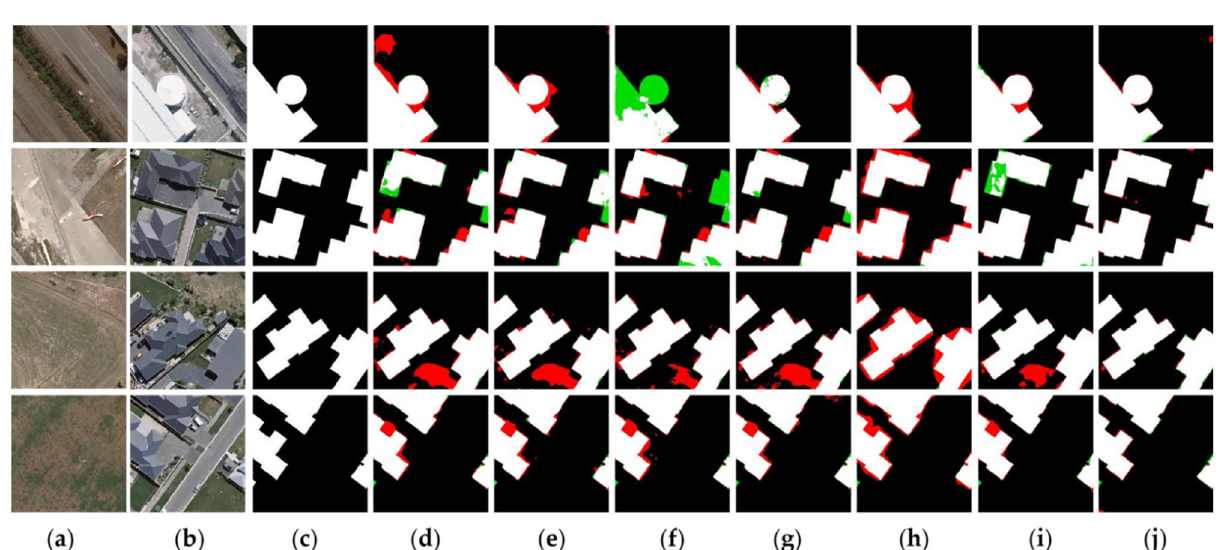
Figure 7. Bi-temporal remote sensing images from WHU-CD dataset. The ( a ) are change before images; the ( b ) are change after images; the ( c ) represents the changed areas and the unchanged areas; ( d ) are results obtained by CDNet; ( e ) are results obtained by FC-EF; ( f ) are results obtained by FC-Siam-Diff; ( g ) are results obtained by FC-Siam-Conc; ( h ) are results obtained by DASNet; ( i ) are results obtained by STANet; ( j ) are results obtained by MFPF-Net (created by ‘Microsoft Office Visio 2013’ url: https:// www. micro soft. com/ zh- cn/ micro soft- 365/ previ ous- versi ons/ micro soft- visio-